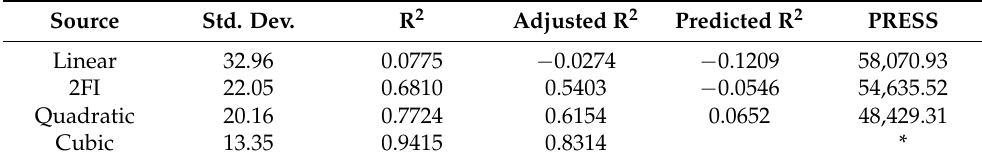
Table 2. Model Summary Statistics.